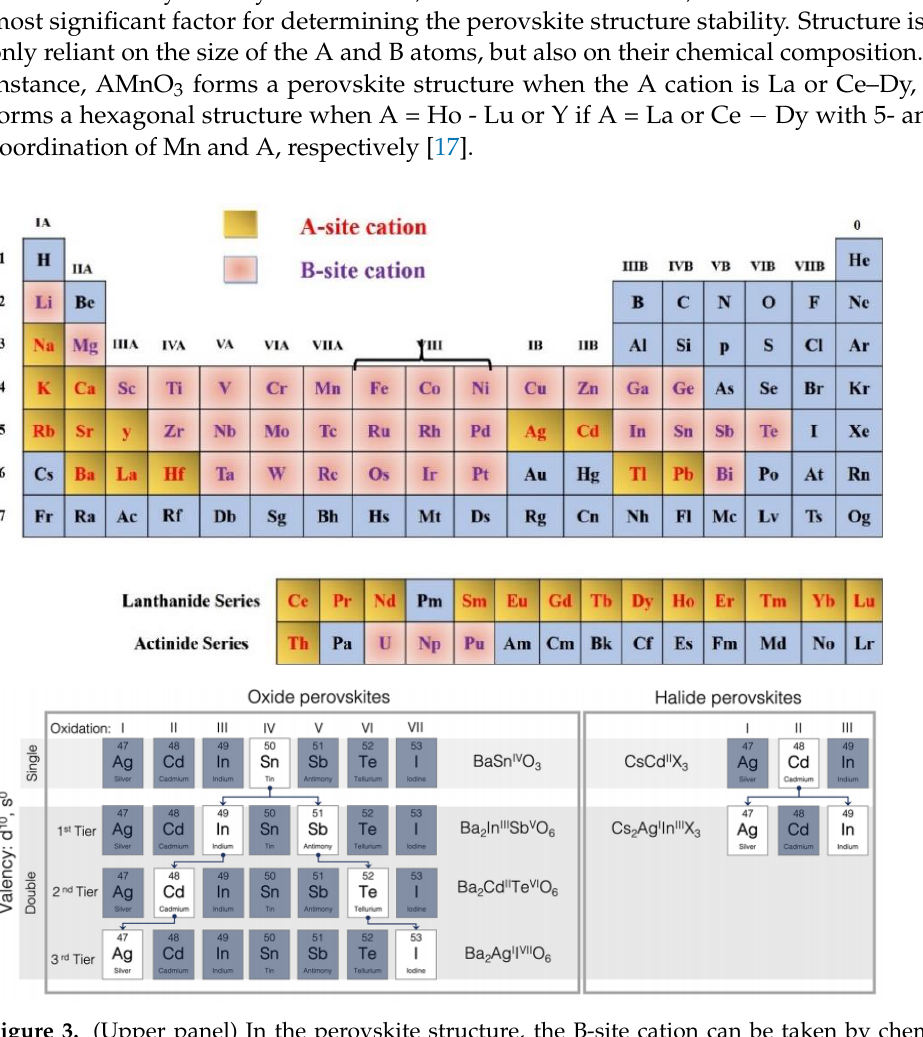
Figure 3. (Upper panel) In the perovskite structure, the B-site cation can be taken by chemical elements. (Lower panel) Representation of the oxide family ( left ), halides ( right ), single ( top ), and double ( below ) perovskites, and other analogs.